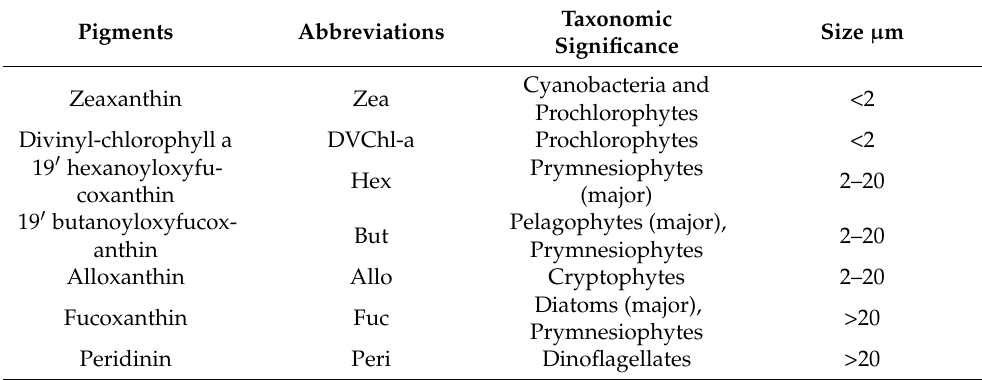
Table 1. Phytoplankton diagnostic pigments, abbreviations, taxonomic significance and size classes (from [51]). Pigments Abbreviations